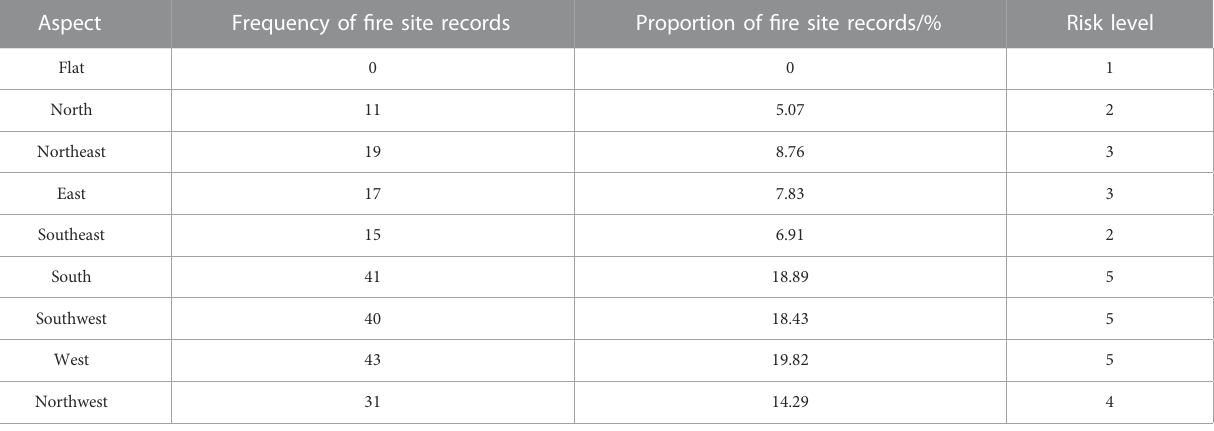
TABLE 4 Classi fi cations of aspects.